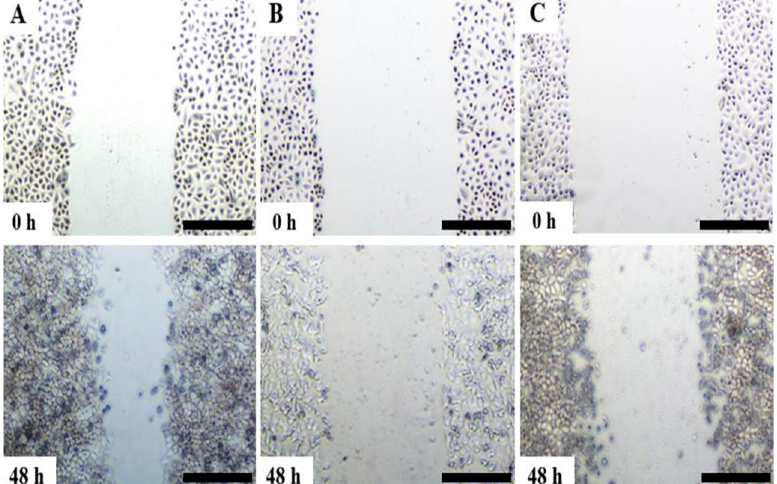
Figure 2. Migration inhibitory effects of Hs.Cas9.MMP8.1.AA ( B ) and Hs.Cas9.MMP8.1.AB( C ) on A549 cells. The treatment on A549 cell line was observed for cell migration rate by using scratch assay. The scratch on A549 cell monolayer was created with 200 µL pipette tips and the cells were then viewed under microscope at 0 h prior to treatment. After 48 h, the distance of cell migration was analysed and measured. The treatment groups were compared with the control non-transfected cells ( A ). Scale 500 µm. ( n = 3).